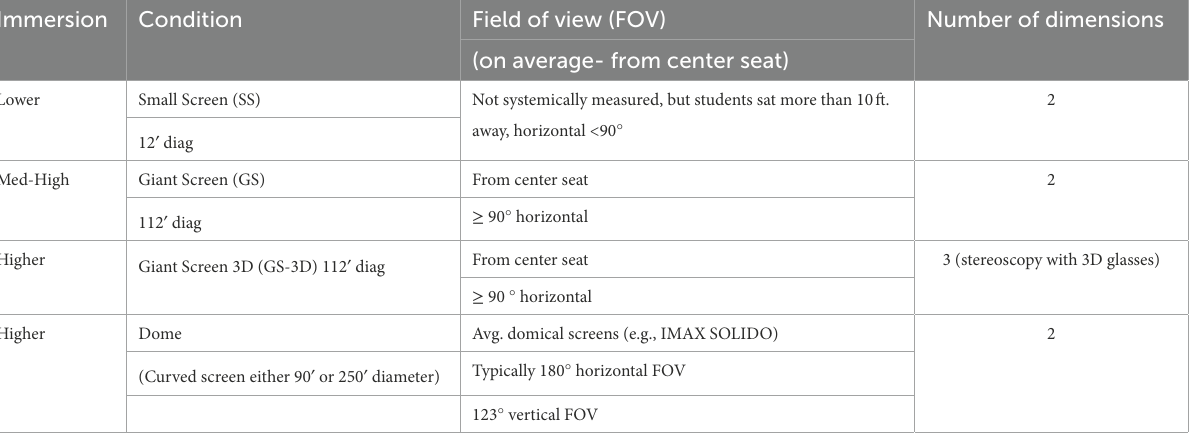
TABLE 1 Levels of immersivity by FOV by number of dimensions (2D vs.